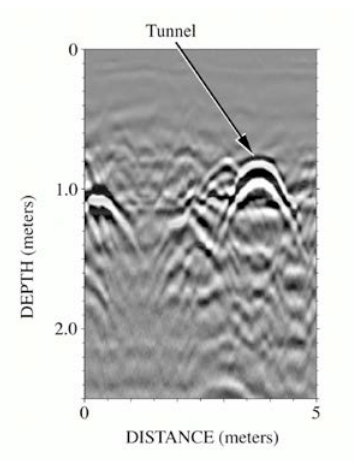
Figure 7. Reflection hyperbolas.